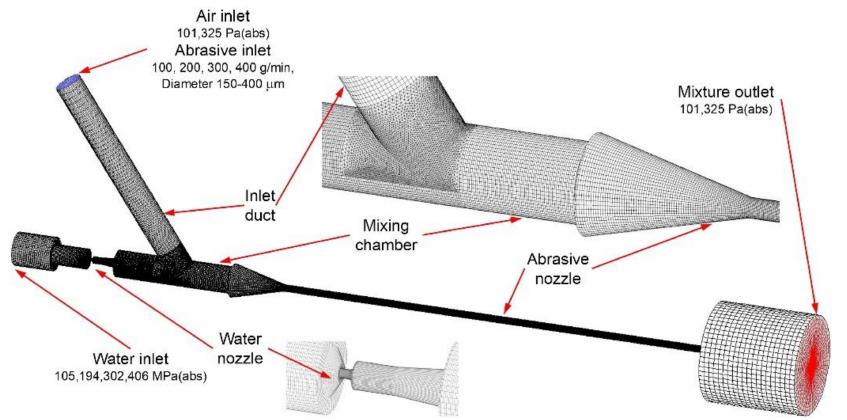
Figure 3. Mesh of the computational domain with boundary